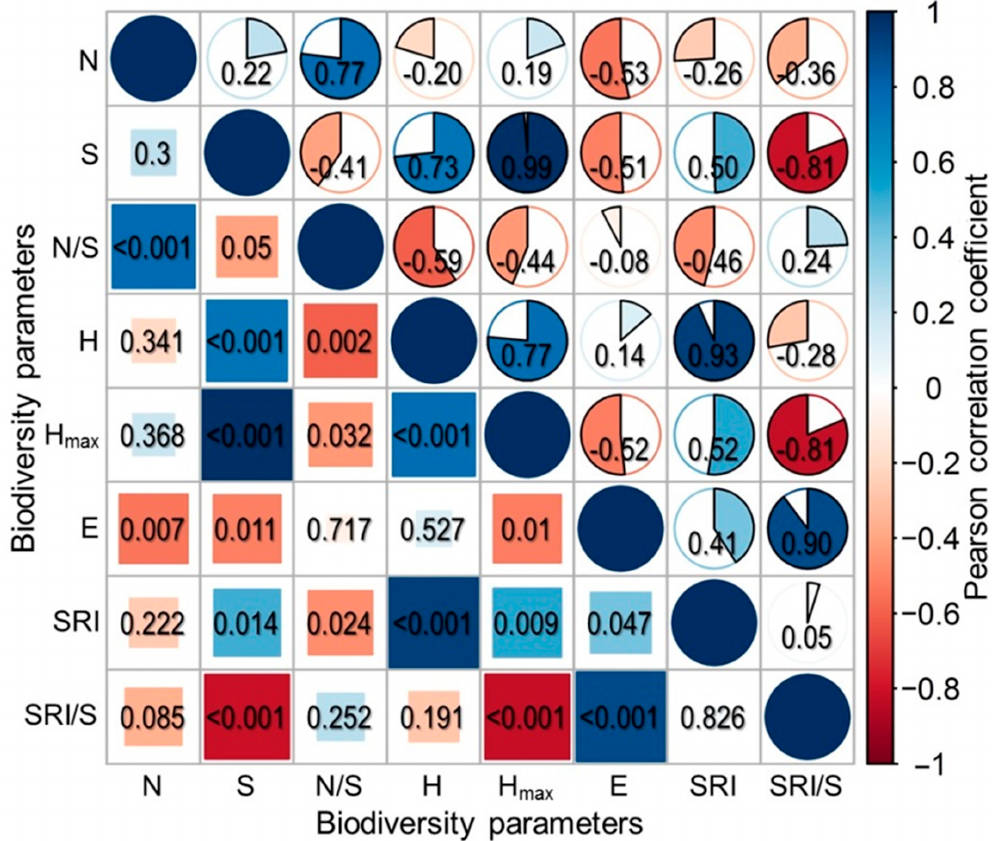
Figure 4. Correlation matrix between diversity indices of scorpions in the Sahara Desert of Algeria (Values above diagonal are Pearson’s correlation coefficients, and figures below diagonal represent p -values).